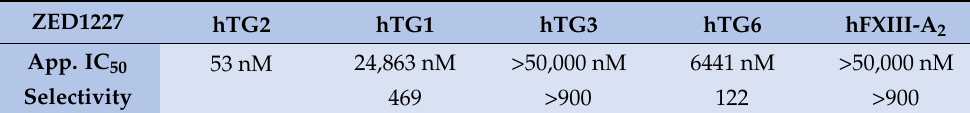
Table 2. Potency and selectivity of ZED1227 against recombinant human transglutaminase